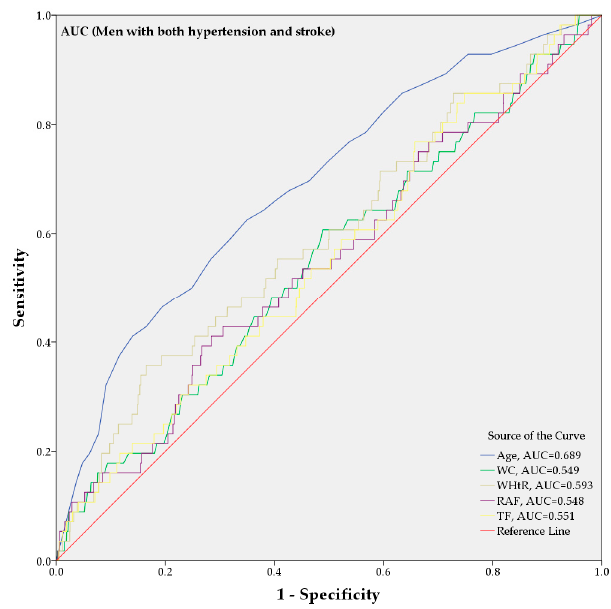
Figure 5. AUC analysis of both hypertension and stroke based on anthropometrics and body composition in men.